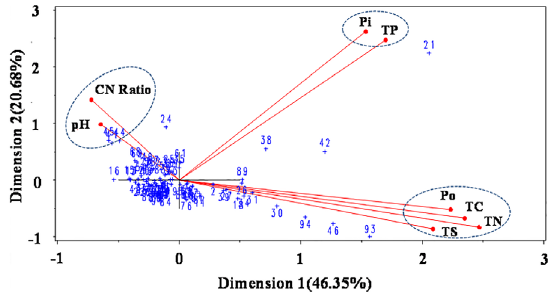
Fig 5. Biplot of sediment properties and sediment P among sample